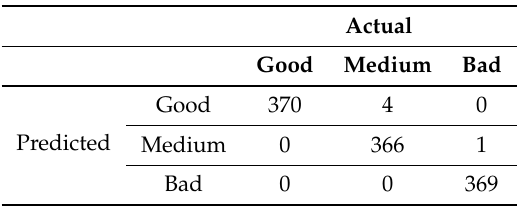
Table 2. Confusion